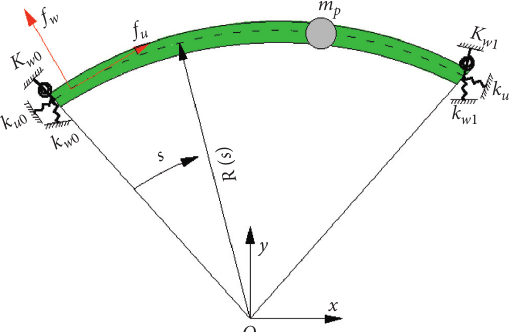
Figure 2: In-plane vibration model of a curved beam supported elastically at both